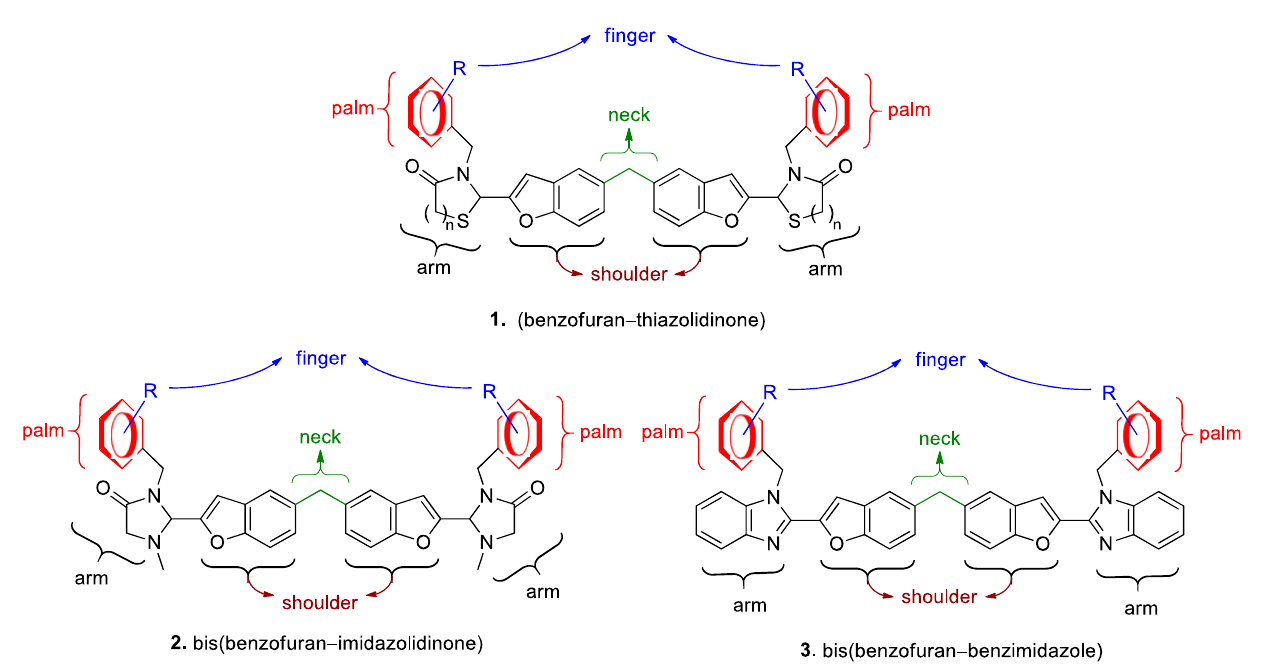
Figure 1. Design of targeted bis(benzofuran–imidazolidinone)s and bis(benzofuran–benzimidaz- ole)s.